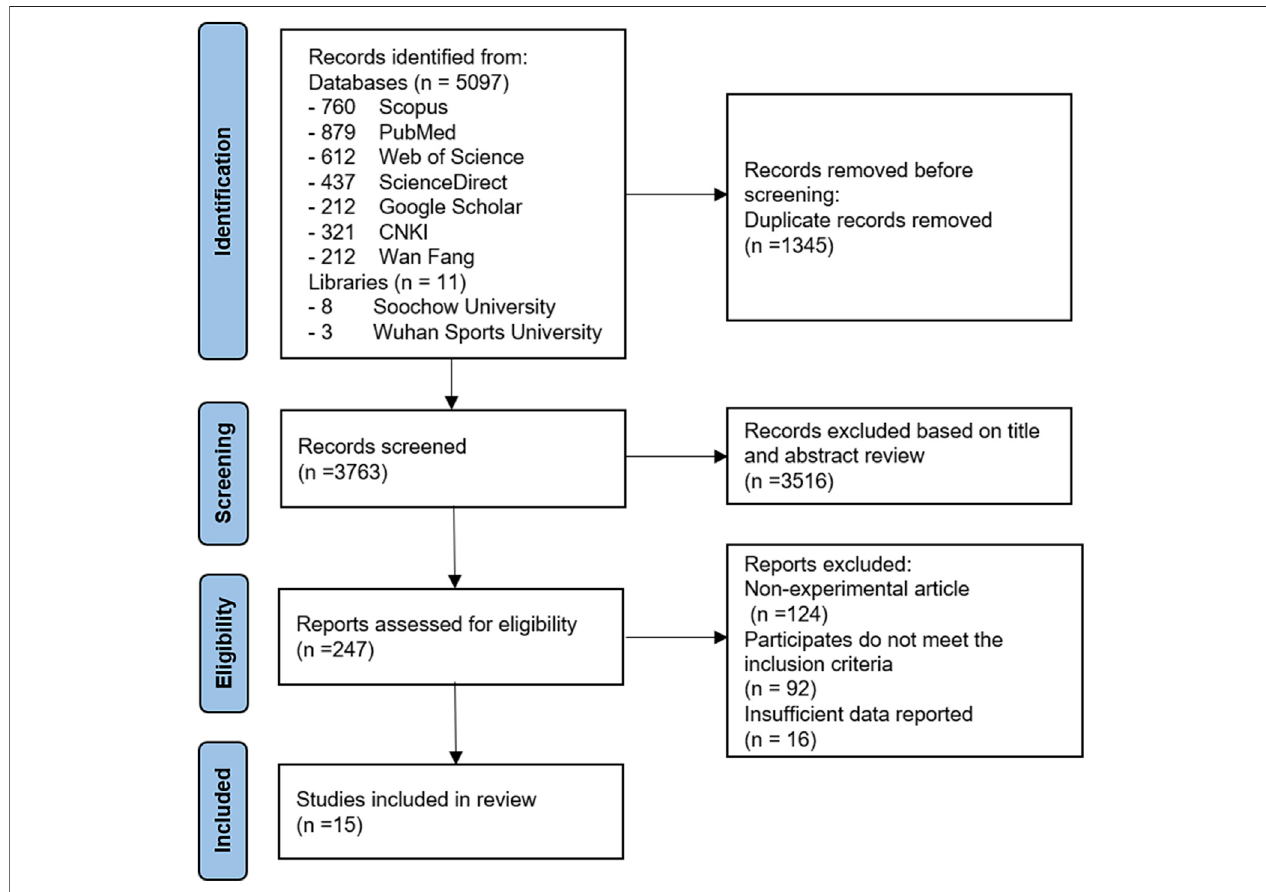
FIGURE 1 | Flow diagram of study selection